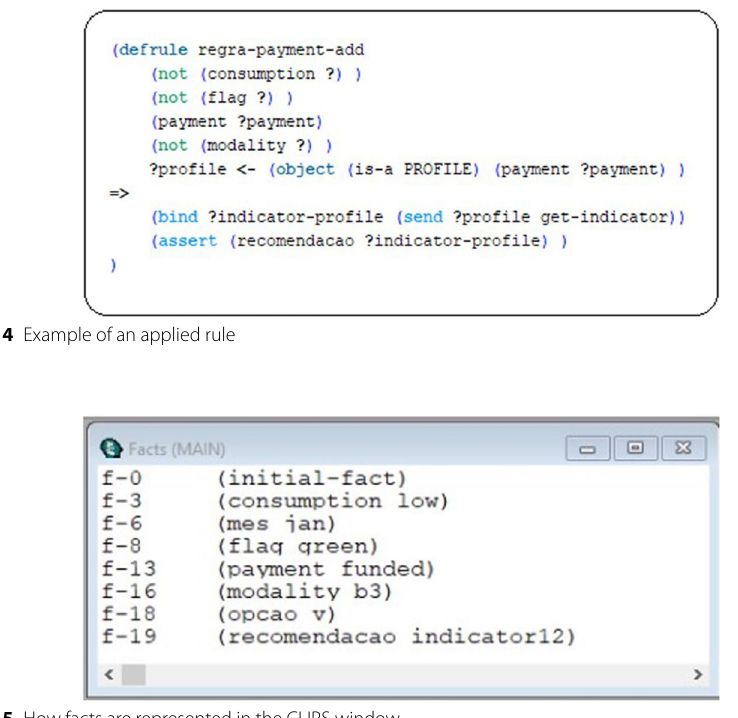
Fig. 5 How facts are represented in the CLIPS